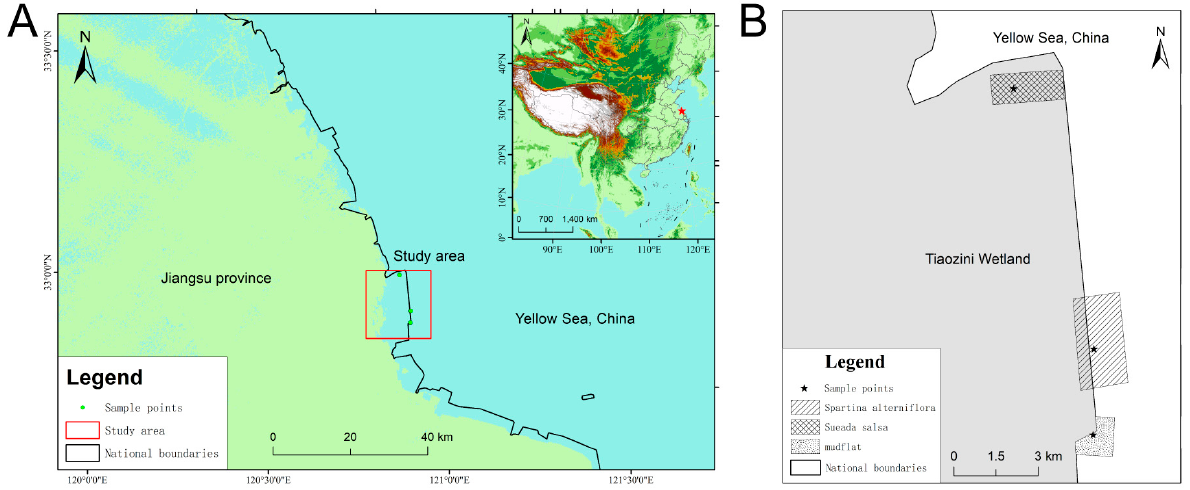
Figure 1. Study area diagram ( A ) and distribution diagram of sampling points ( B ). Table 1. Sample collection area information and partial physicochemical properties